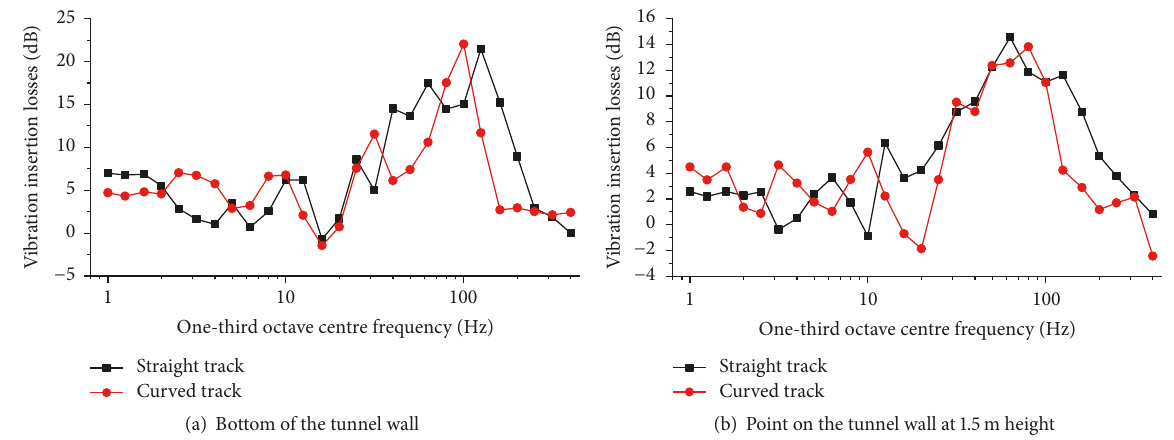
Figure 18: Insertion loss of vibration levels at the tunnel wall.